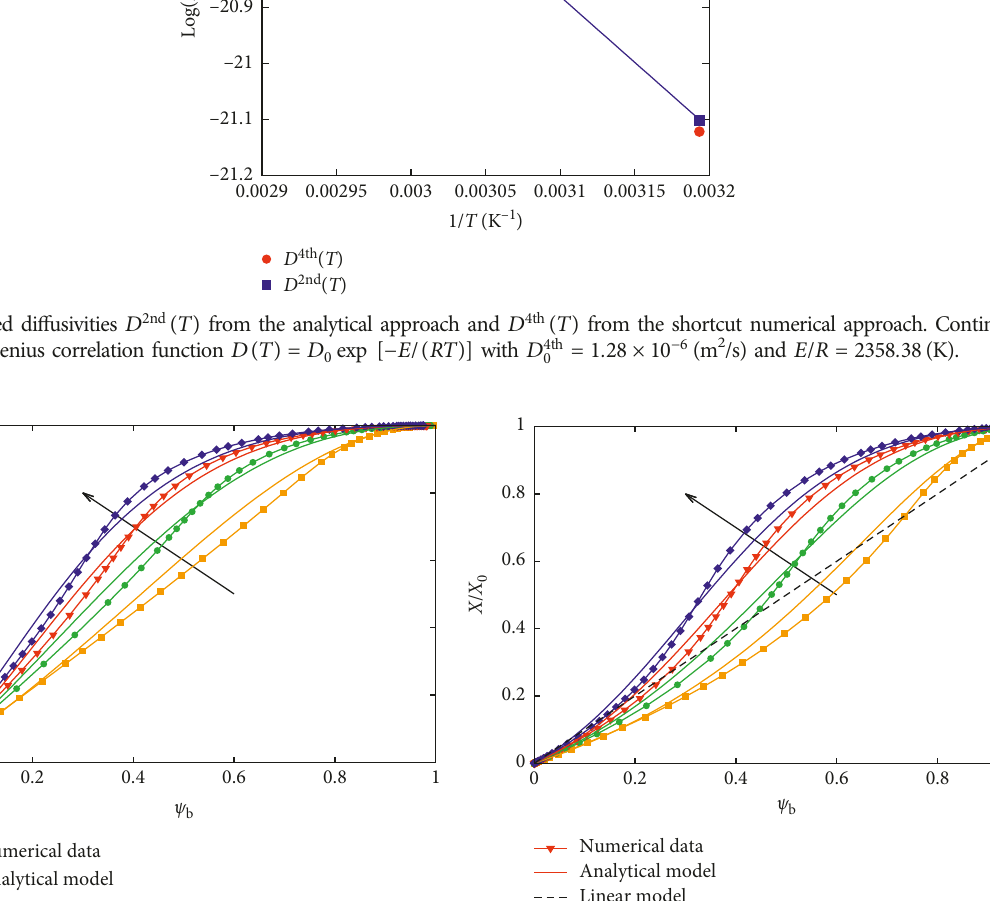
Figure 8: Numerical results for ψ Continuous lines represent the nonlinear model predictions (equation (C.1) for ψ av and equations (19) and (C.1) for X / X 0